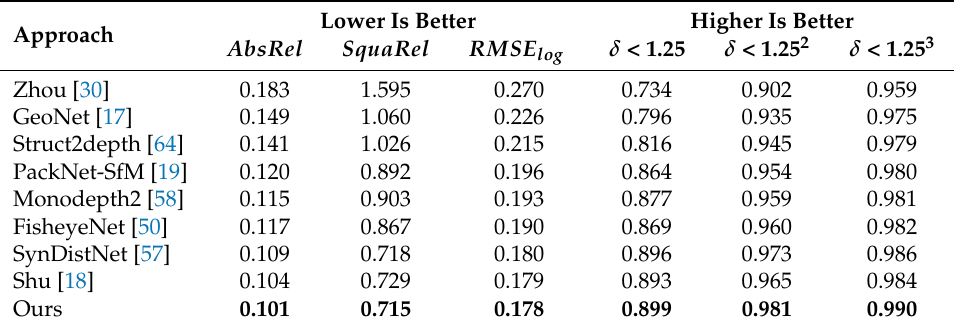
Table 3. Quantitative performance comparison of our network with other self-supervised monocular methods for the KITTI